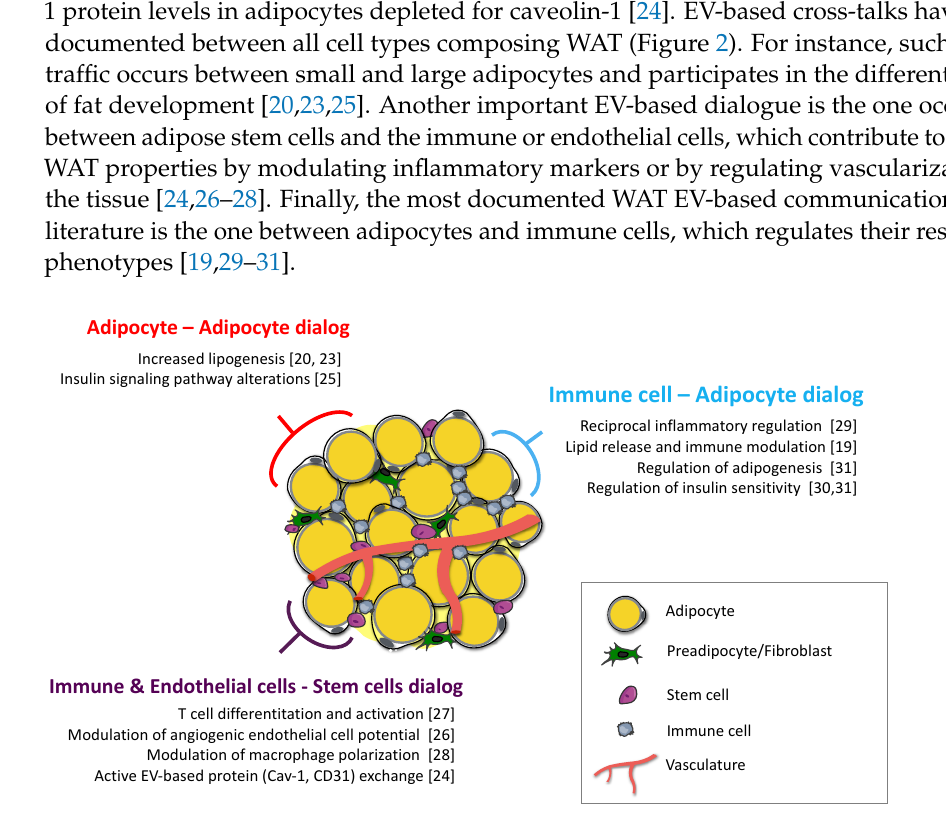
Figure 2. Cellular EV-based cross-talks between adipose tissue modulate fat metabolism by autocrine action. EV-based dialog within white adipose tissue (WAT) has been evidenced between the different fat cell types as illustrated between adipocytes themselves, or between stem cells/immune cells and endothelial cells and between immune cells and adipo- cytes. All these exchanges result in modulating cell recipients ’ metabolic responses and participate in maintaining fat homeostasis. The references of the publications cited as examples are given in brackets.